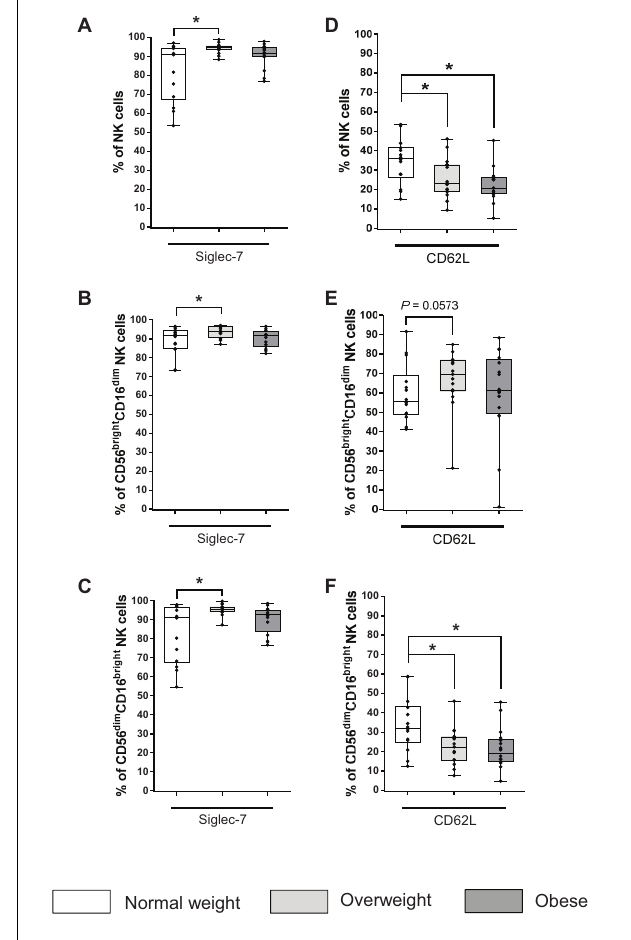
FIGURE 4 | Frequencies of NK cells and NK cell subsets expressing the inhibitory receptor Siglec-7 (A–C) and the adhesion molecule CD62L (D–F) in peripheral blood mononuclear cells (PBMCs) isolated from normal weight ( n = 14), overweight ( n = 16), and obese ( n = 16) healthy blood donors. Percentage of Siglec-7 + total NK cells (A) , CD56 bright CD16 dim NK cells (B) , and CD56 dim CD16 bright NK cells (C) . Percentages of CD62L + total NK cells (D) , CD56 bright CD16 dim NK cells (E) , and CD56 dim CD16 bright NK cells (F) . Graphs are box and whisker plots with median ± minimum to maximum value; with additional dot plot representing individual donors. Overweight and obese groups were compared to normal weight control group. Statistical significance is indicated as: * P ≤ 0.05; P -value within 0.05 ≤ P ≤ 0.1 is indicated with precise P -values.